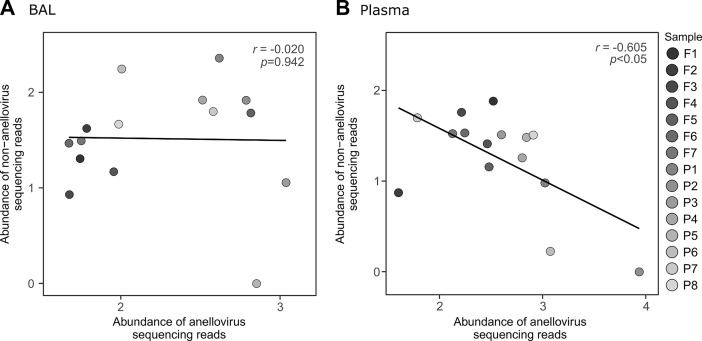
Relation between the abundance of anelloviruses and of other eukaryotic viruses.(A) and (B) Abundance of anelloviruses (Log10) versus the abundance of other eukaryotic viruses (non-anelloviruses) in BAL and plasma of 15 LTRs, respectively. Only one sample per patient was used for this analysis, for the time points closer to 87 days after transplantation.